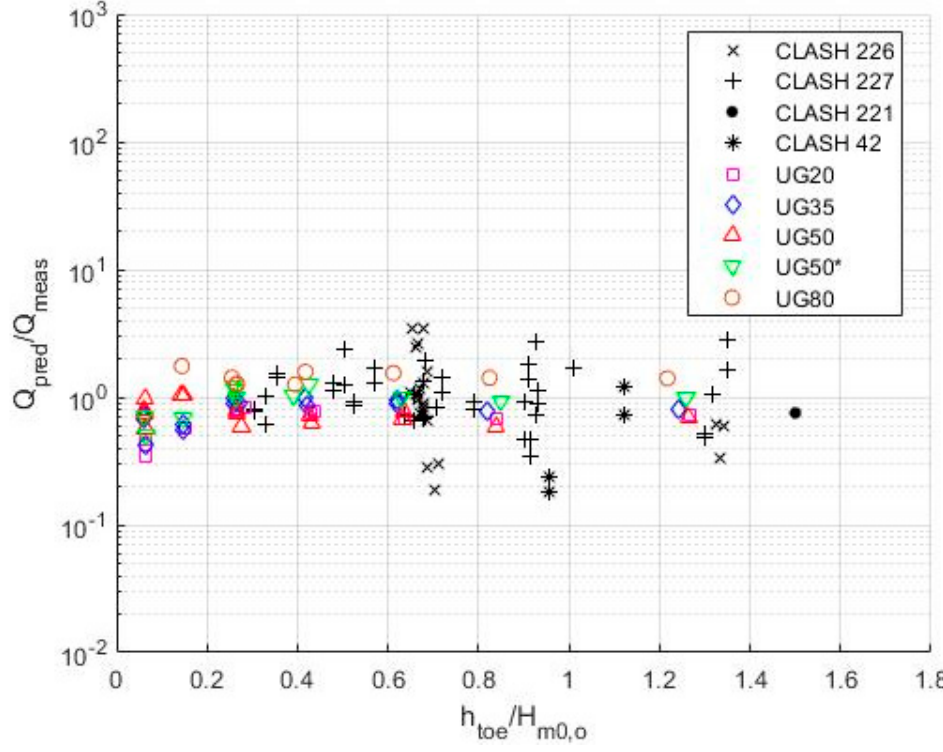
Figure 11. Ratio of dimensionless predicted by Altomare et al. [2] to measured overtopping discharge versus the relative water depth.